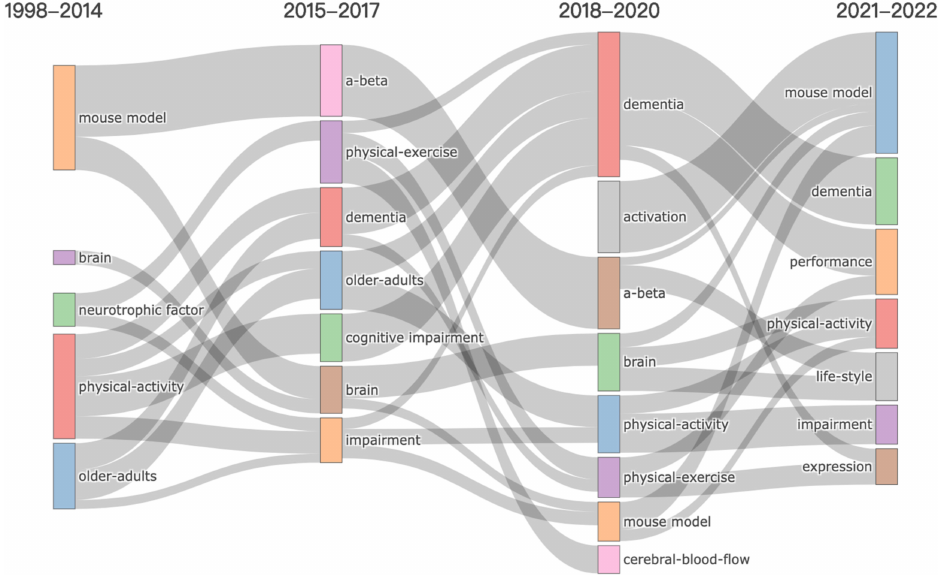
Figure 11. Thematic trend of AD exercise